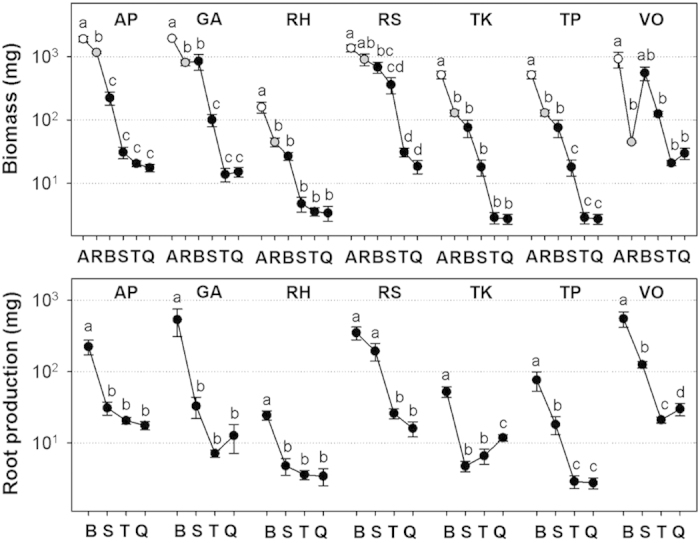
Total biomass of aboveground component (A, open circle), rhizome or root collar (R, grey circle), basal roots (B), secondary roots (S), tertiary roots (T) and quaternary roots (Q) and annual root production of each branching level among seven species.Lowercase letters within a species indicate significant (P < 0.05) differences among different plant components and each root branching level. Abbreviations of species names are shown in Table 1.